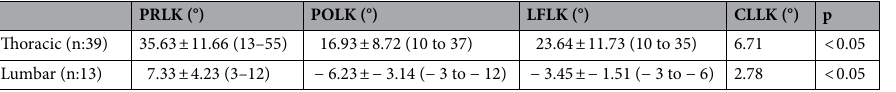
Table 1. The average preoperative (PR) and postoperative (PO) local kyphosis (LK), values of correction loss (CL) and last follow-up (LF) of the patients according to vertebral regions. n number of